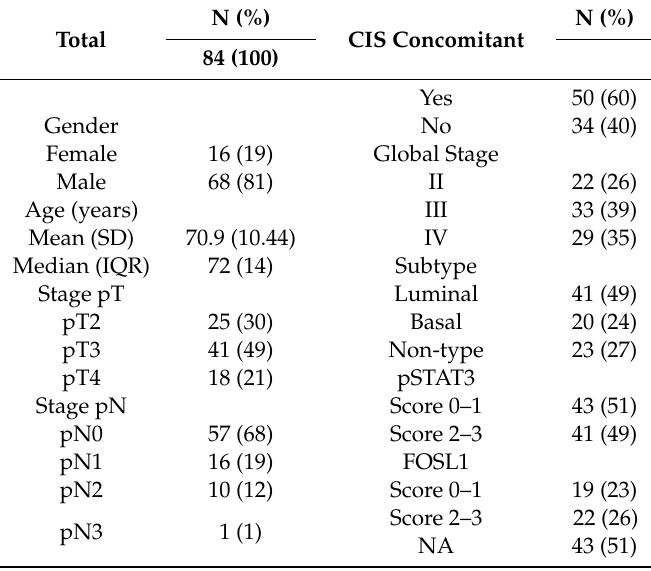
Table 1. Demographic, histological, and clinical data of the MIBC patient cohort. CIS, carcinoma in situ; SD, standard deviation; IQR, interquartile range; NA, not available.